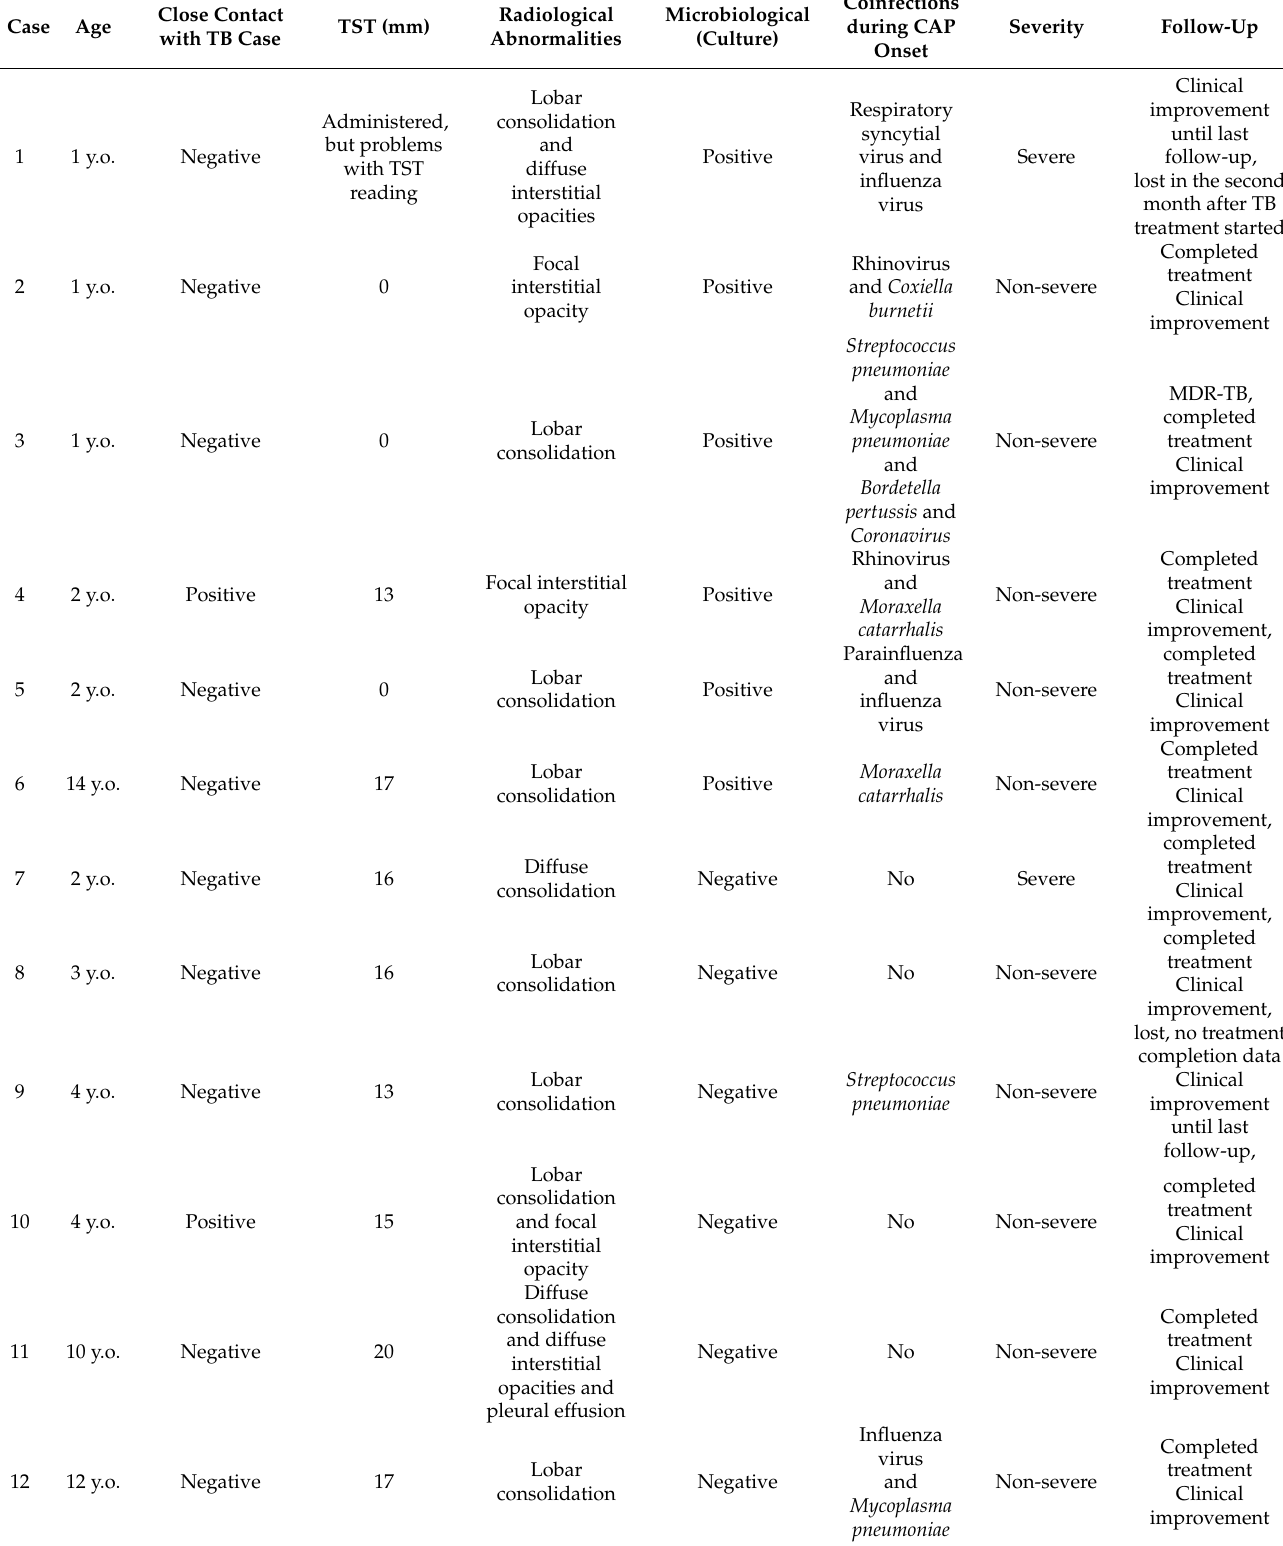
Table 2. Radiological, epidemiological, tuberculin skin test, and microbiological characteristics in 12 children and adolescents with community-acquired pneumonia and intrathoracic